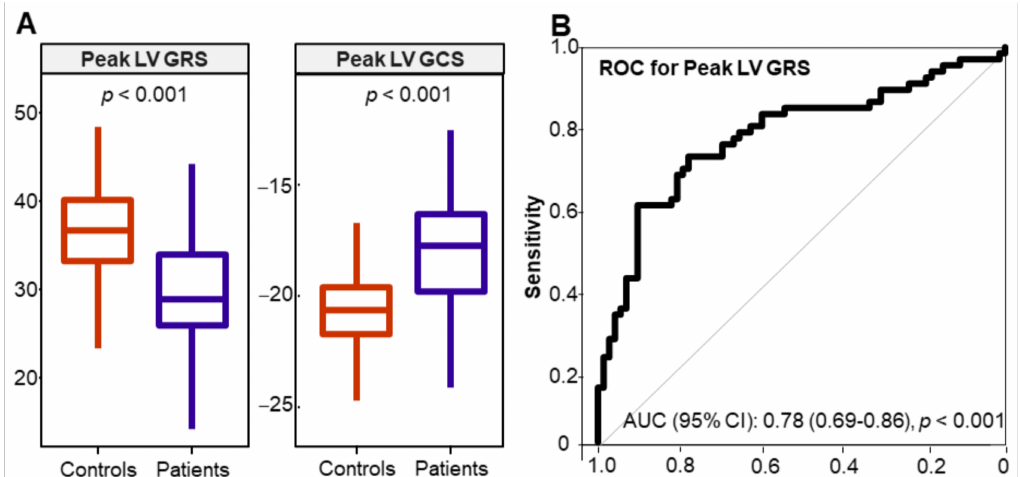
Figure 3. ( A ) Box plots showing the median values of the peak left ventricular global radial strain (LV GRS) and the peak left ventricular global circumferential strain (LV GCS) in control subjects and patients with ventricular arrhythmia. ( B ) Receiver operating characteristic (ROC) curve for the peak left LV GRS; the curve shows a good ability of the peak LV GRS to differentiate the patients from the control subjects. AUC: area under the